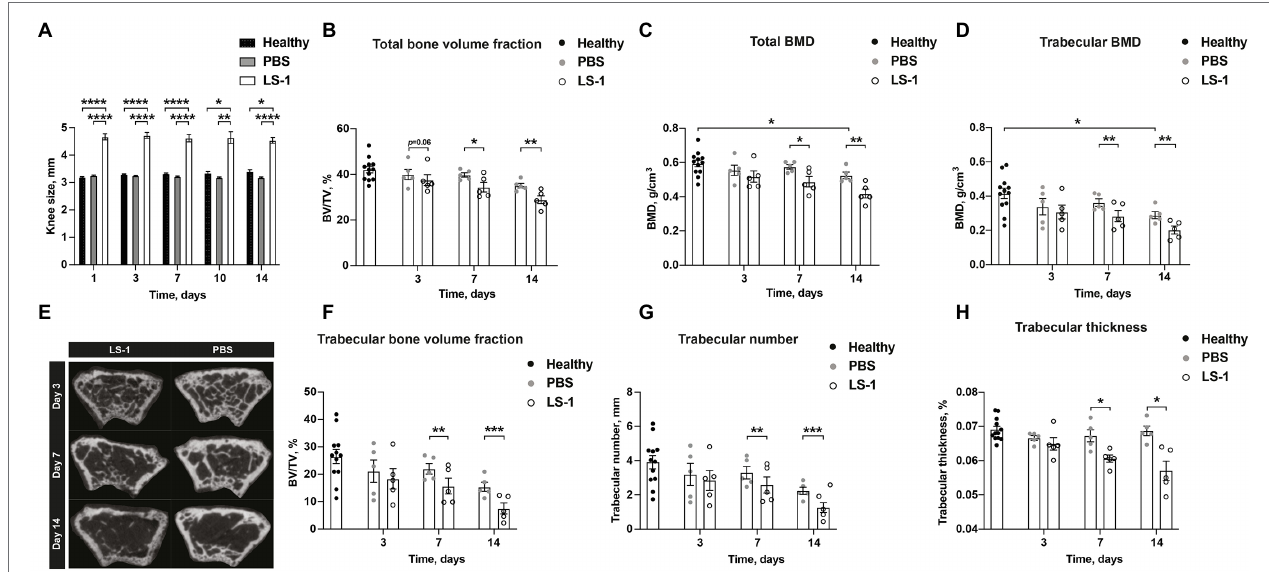
FIGURE 1 | Intra-articular injection of Staphylococcus aureus LS-1 strain induces bone resorption. (A) Measurement of knee swelling (mm) in NMRI mice up to 14 days after intra-articular (i.a.) injection with 20 μ l of Staphylococcus aureus ( S. aureus ) LS-1 strain (1 × 10 4 CFU/knee) or 20 μ l of phosphate-buffered saline (PBS; n = 5/group), compared with healthy NMRI mice ( n = 6; n = 12 knee joints) i.a. injected with 20 μ l of PBS. (B) The total bone volume fraction [bone volume/tissue volume (BV/TV)] measured in NMRI mice up to 14 days after i.a. injection with 20 μ l of S. aureus LS-1 strain [1 × 10 4 CFU/knee] or 20 μ l of PBS ( n = 5/group), compared with healthy NMRI mice ( n = 6; n = 12 knee joints) i.a. injected with 20 μ l of PBS. (C) The total- and (D) trabecular bone mineral density (BMD, g/cm 3 ). (E) Representative 2D microcomputed tomography (micro-CT) images of the femoral metaphysis of mice i.a. injected with S. aureus LS-1 (left panel) and PBS (right panel) on days 3 (upper), 7 (middle), and 14 (lower) post injection. Graphs showing quantitative evaluation of (F) trabecular bone volume fraction (BV/TV), (G) trabecular number, and (H) trabecular thickness. Statistical evaluations were performed using the Mann–Whitney U test between healthy control mice and PBS injected S. aureus infected mice (A–D,F–H) or Paired t test between S. aureus and PBS injected mice originating from the same host (A–D,F–H) . The data are presented as a bar (A) or scatterplot with data expressed as the mean ± SEM ( B–D , F–H ; * p < 0.05, ** p < 0.01, *** p < 0.001, and **** p <